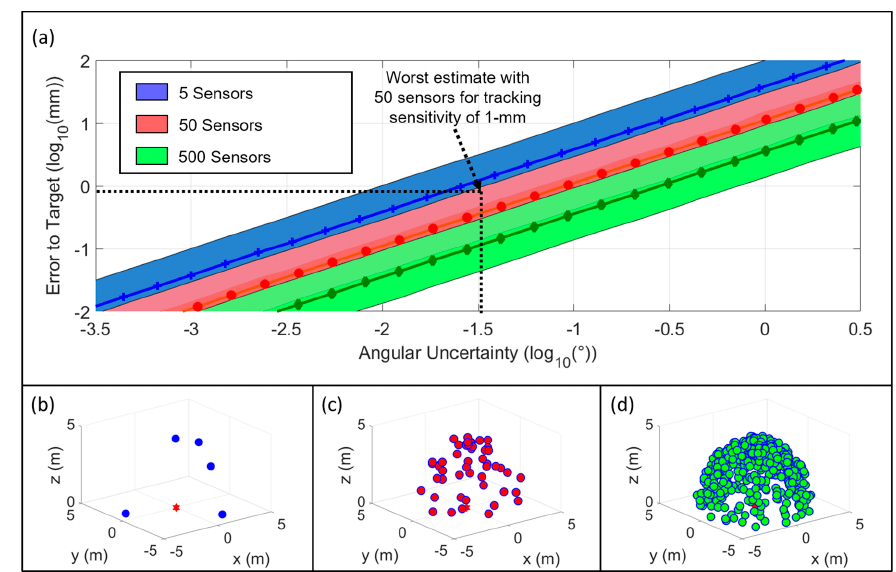
Figure 6. ( a ) Relationship between angular precision and error in least squares estimation of the transmitter position. Filled area represents two standard deviations of Monte Carlo simulation results.